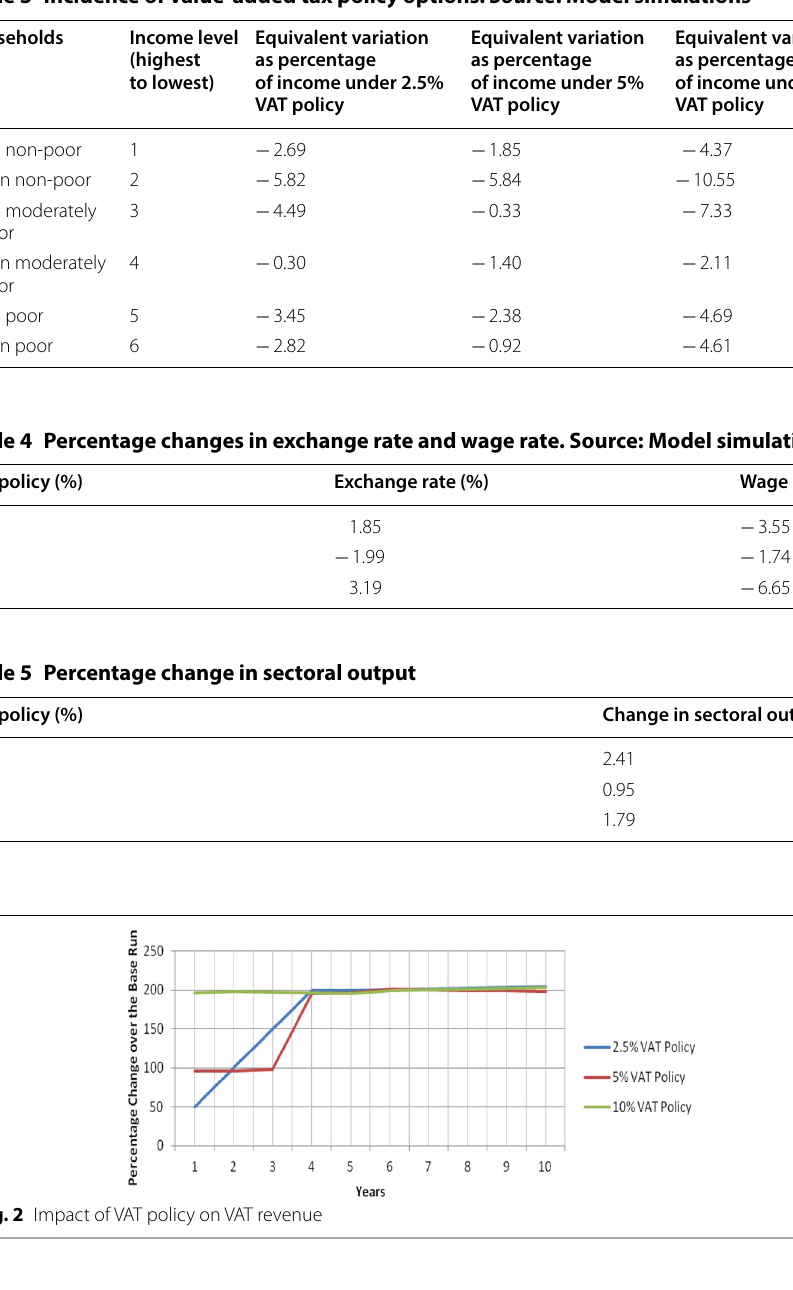
Table 3 Incidence of value‑added tax policy options. Source : Model simulations Households Income level Equivalent variation (highest as percentage